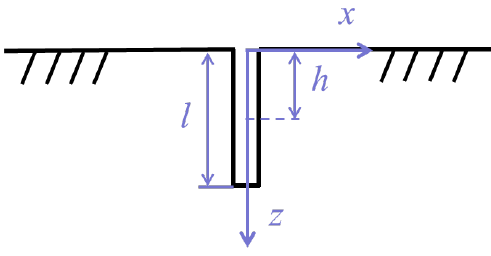
Figure 1. Schematic diagram of a surface crack.